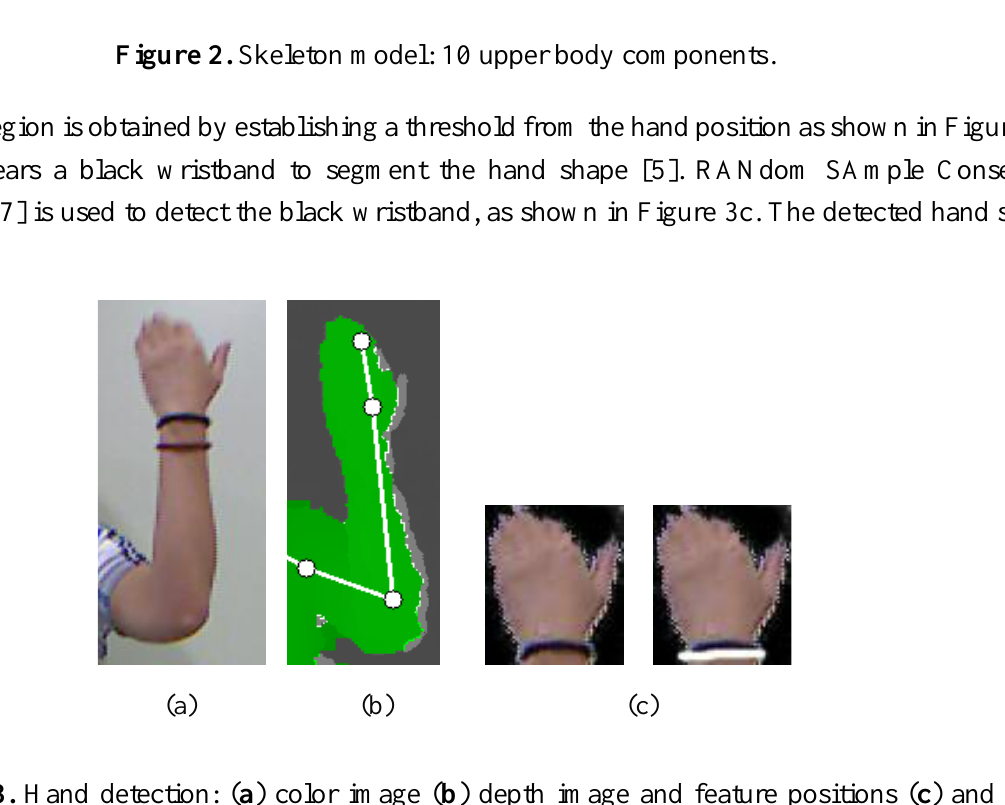
Figure 3. Hand detection: ( a ) color image ( b ) depth image and feature positions ( c ) and detected regions with black